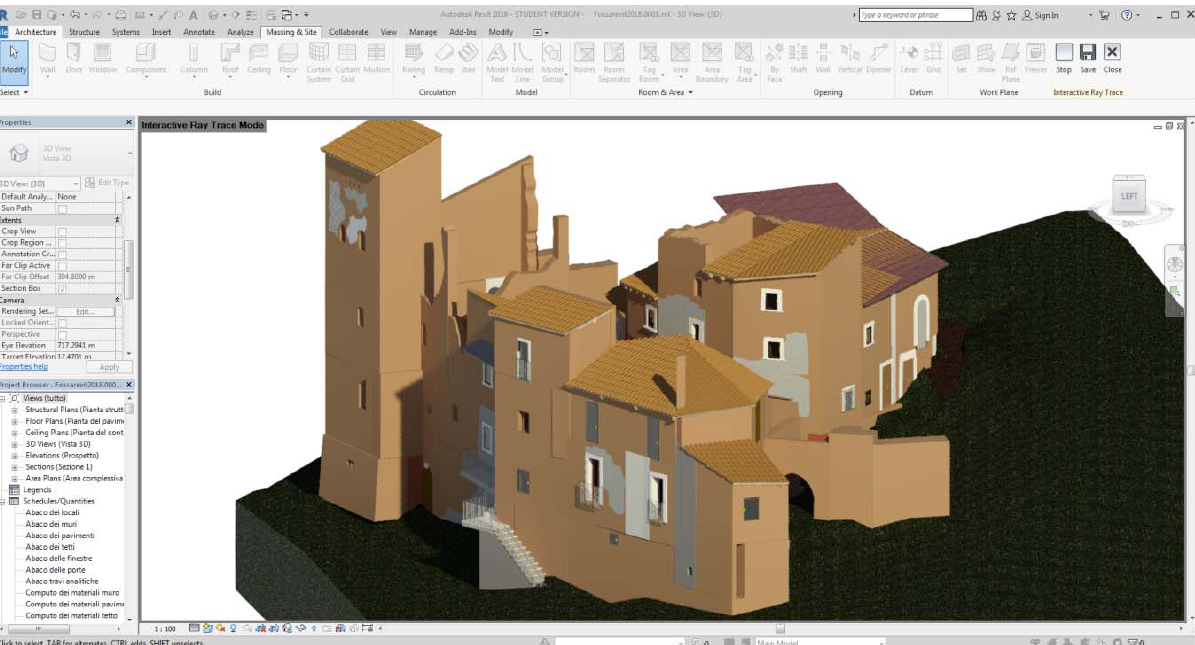
Figure 4: Screenshot of the Revit software with the parametric model of the